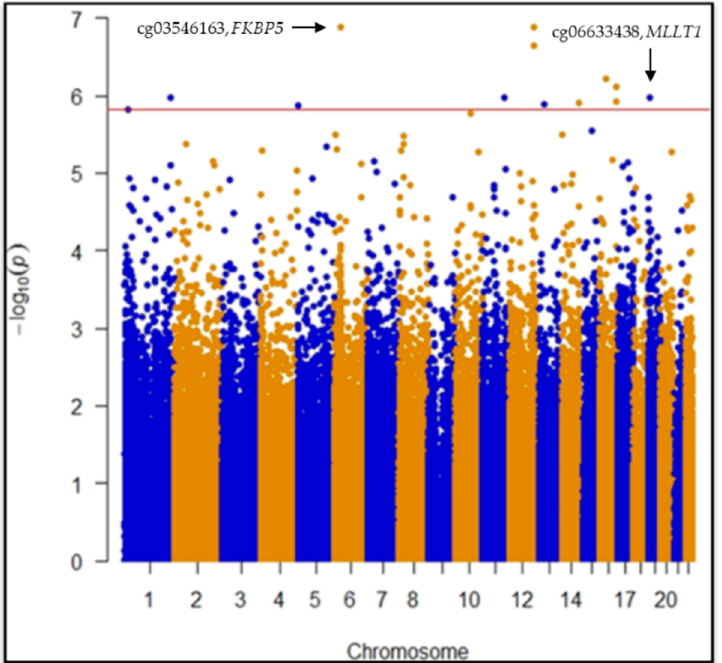
Figure 1. Manhattan plot for EWAS test on 450 k single CpGs. Single-CpG DNAm was used as dependent variable adjusting for age, gender, White blood cells (WBCs: monocytes, granulocytes, natural killer, B cells, CD4+ T and CD8+ T) estimation, population stratification and technical variability. FDR post hoc line highlights statistically significant differences between cases and controls at single CpG level.